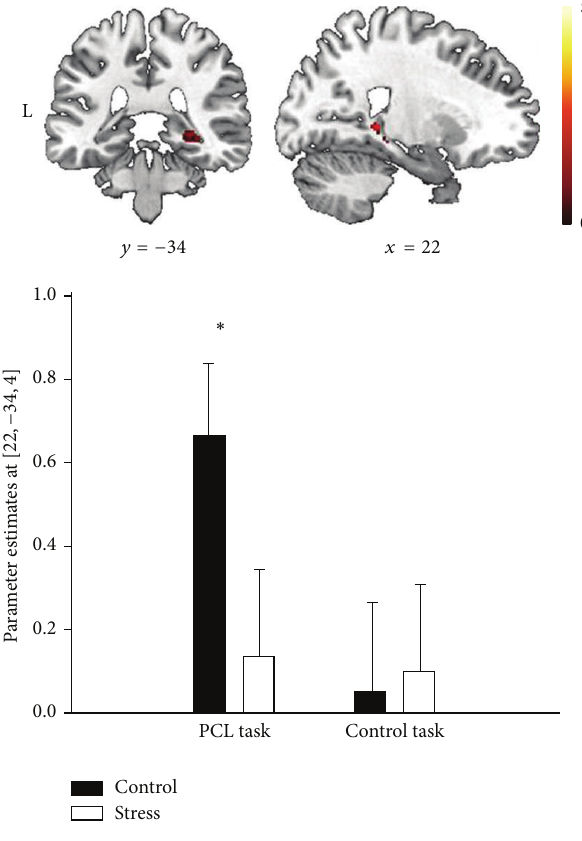
Figure 7: Neuroimaging data assessed during PCL shows less right hippocampal activity during PCL in the stress group compared to the control group